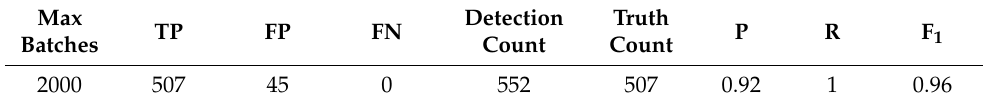
Table 2. Results of true positives, false positives, false negatives, precision, recall, and F 1